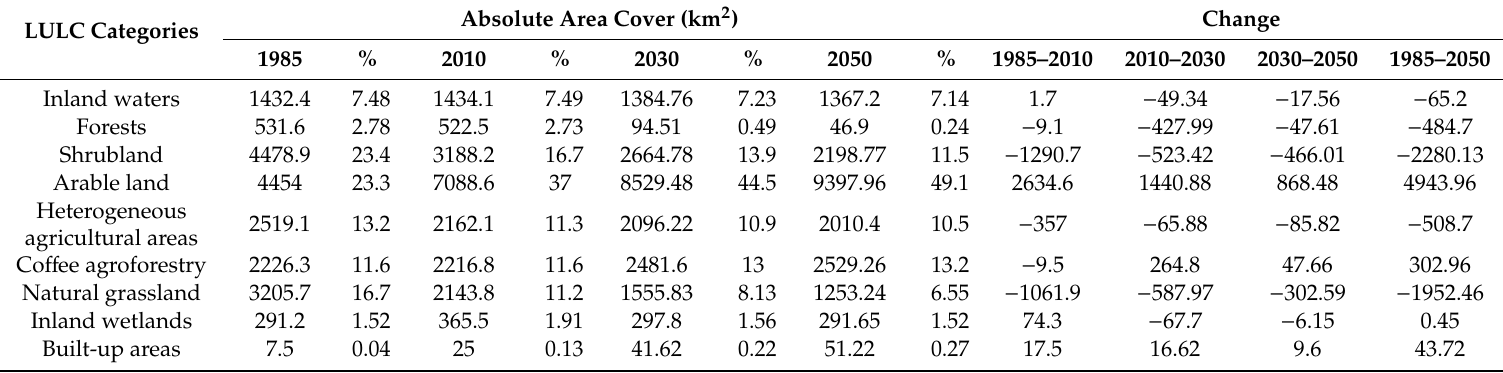
Table 3. Observed (1985 and 2010) and projected (2030 and 2050) LULC and their changes in the ACB. LULC